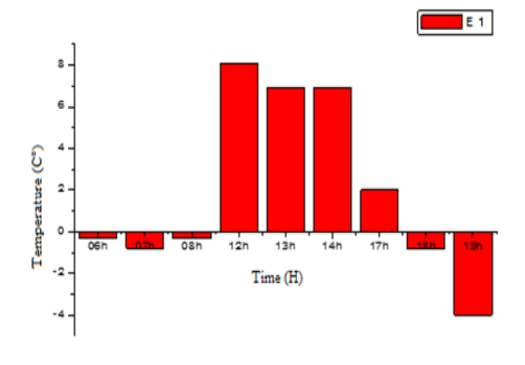
Figure 9. Variation of the internal and external temperature in the room